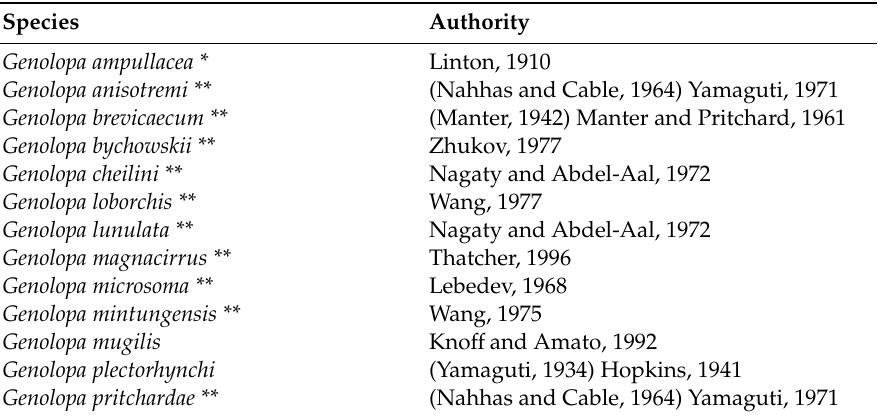
Table 4. Nominal species of Genolopa